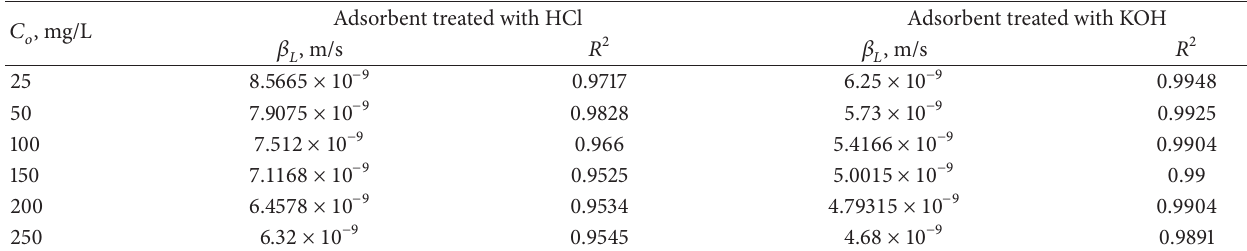
Table 4: Mass transfer coefficients from the Furusawa and Smith model (modified) for the adsorption of phenol. 𝐶 𝑜 , mg/L